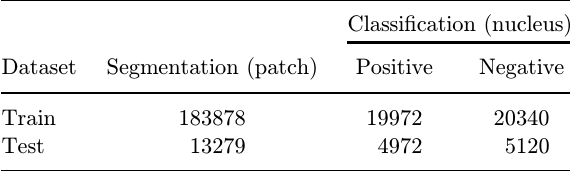
Table 1. Composition of datasets.